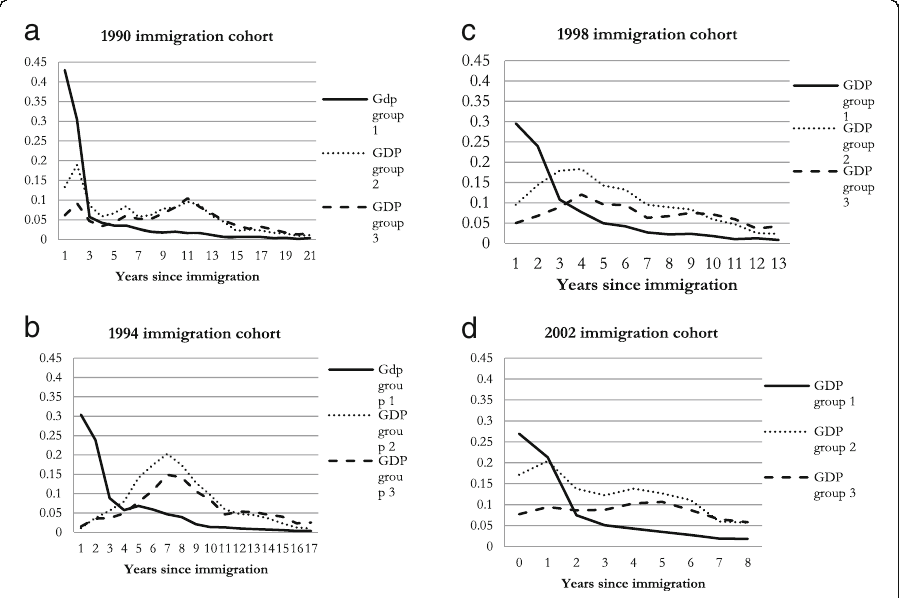
Fig. 5 a – d Hazard rates for time until annual income >2 PBB by immigrant year